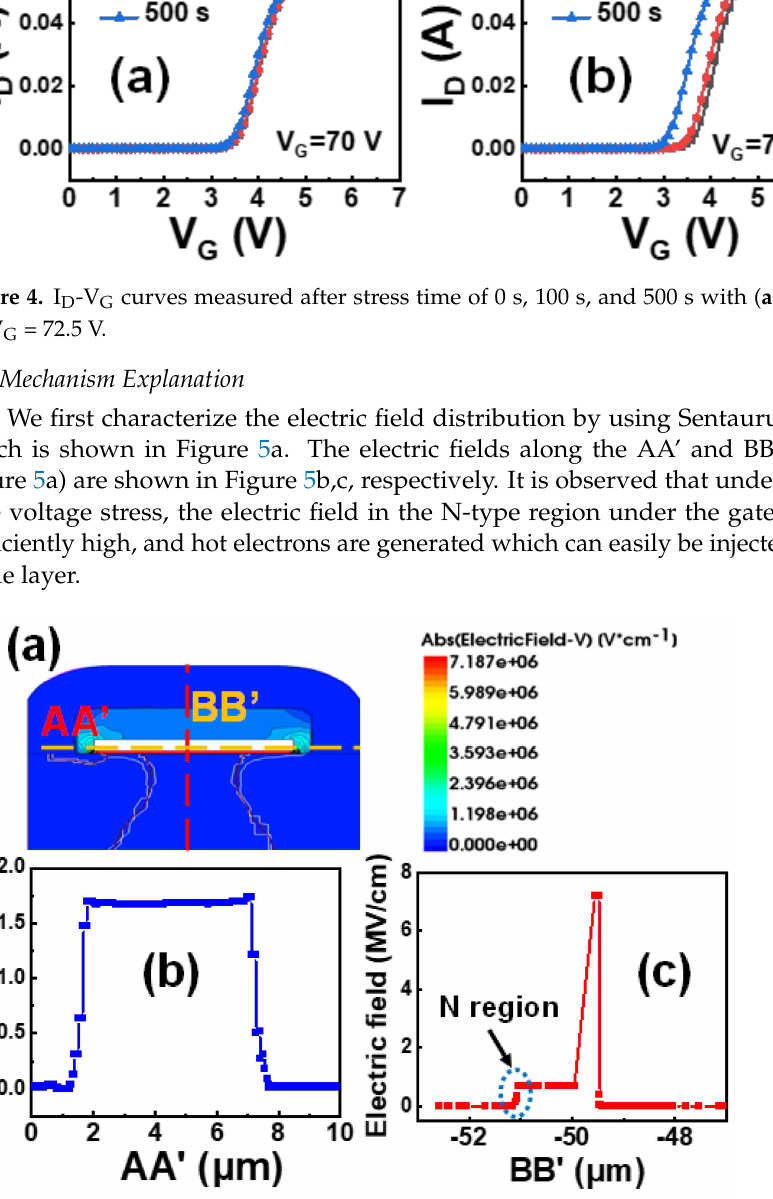
Figure 5. ( a ) Simulated electric field distribution of the designed device cell. ( b ) Electric field distribution along AA’. ( c ) Electric field distribution along BB’.